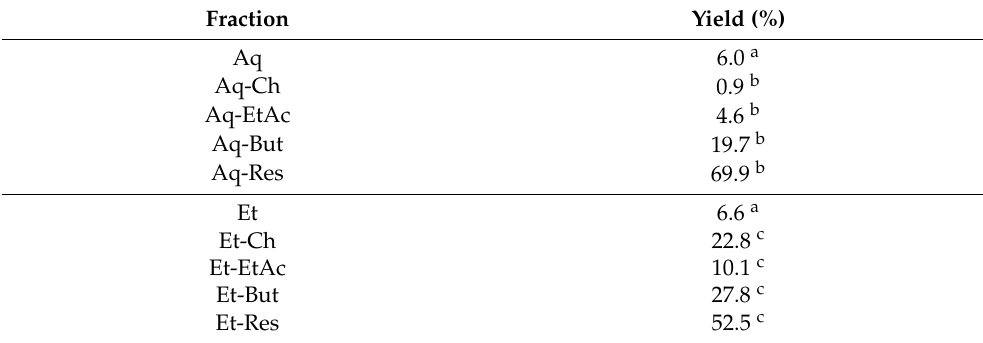
Table 1. Yields of aqueous and ethanolic extracts and their solvent fractions.